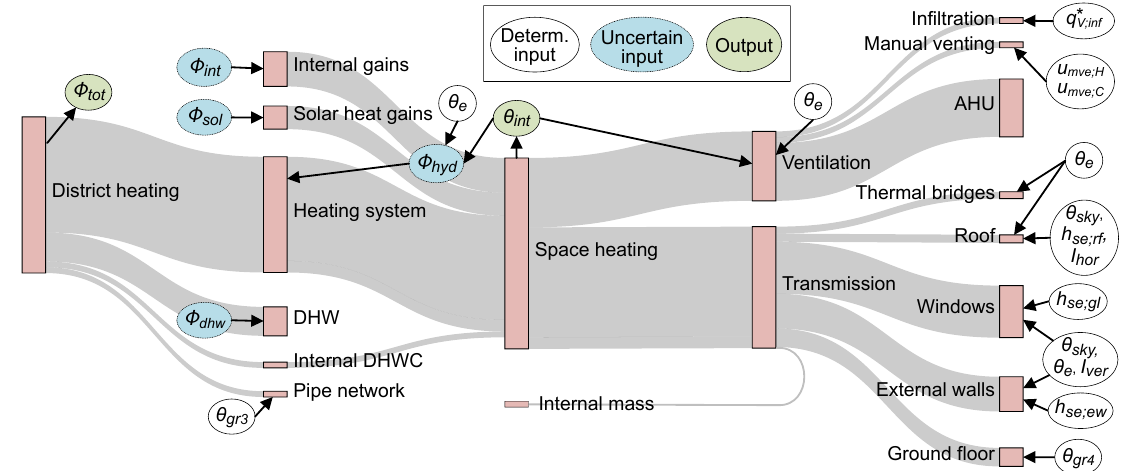
Figure 3. An energy flow diagram showing where the deterministic inputs, uncertain inputs, and uncertain outputs enters the stochastic